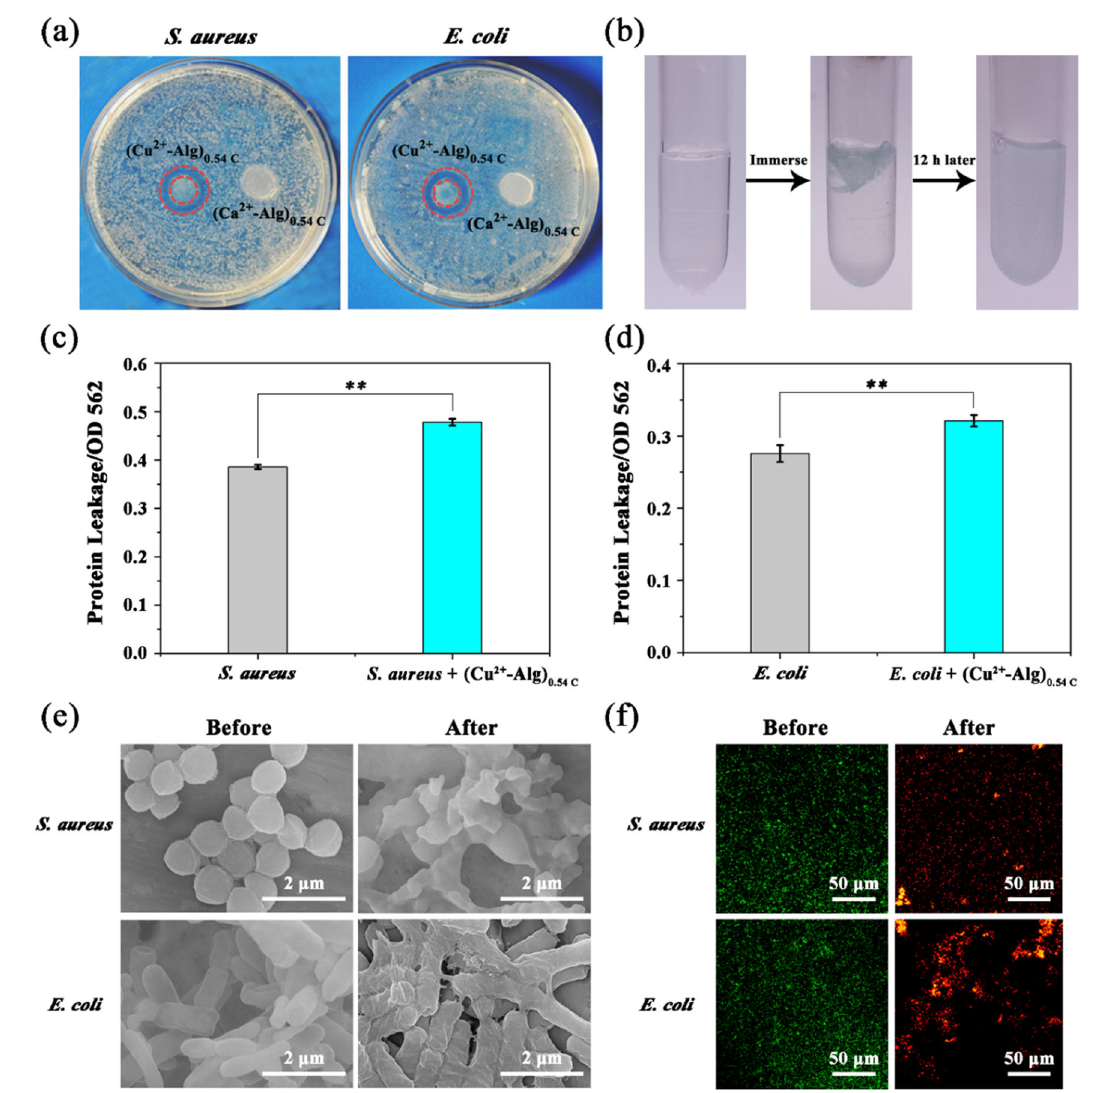
Fig. 4 a (Cu 2 + -Alg) 0.54C fi lm generates a zone of bacteria inhibition in an agar plate assay. b The decomposing process of (Cu 2 + -Alg) 0.54C fi lm in PBS buffer. c Protein leakage of and S. aureus . d E. coli after incubation with (Cu 2 + -Alg) 0.54C fi lm for 10 h. The higher value of OD 562 indicates higher protein leakage, which originates from cell